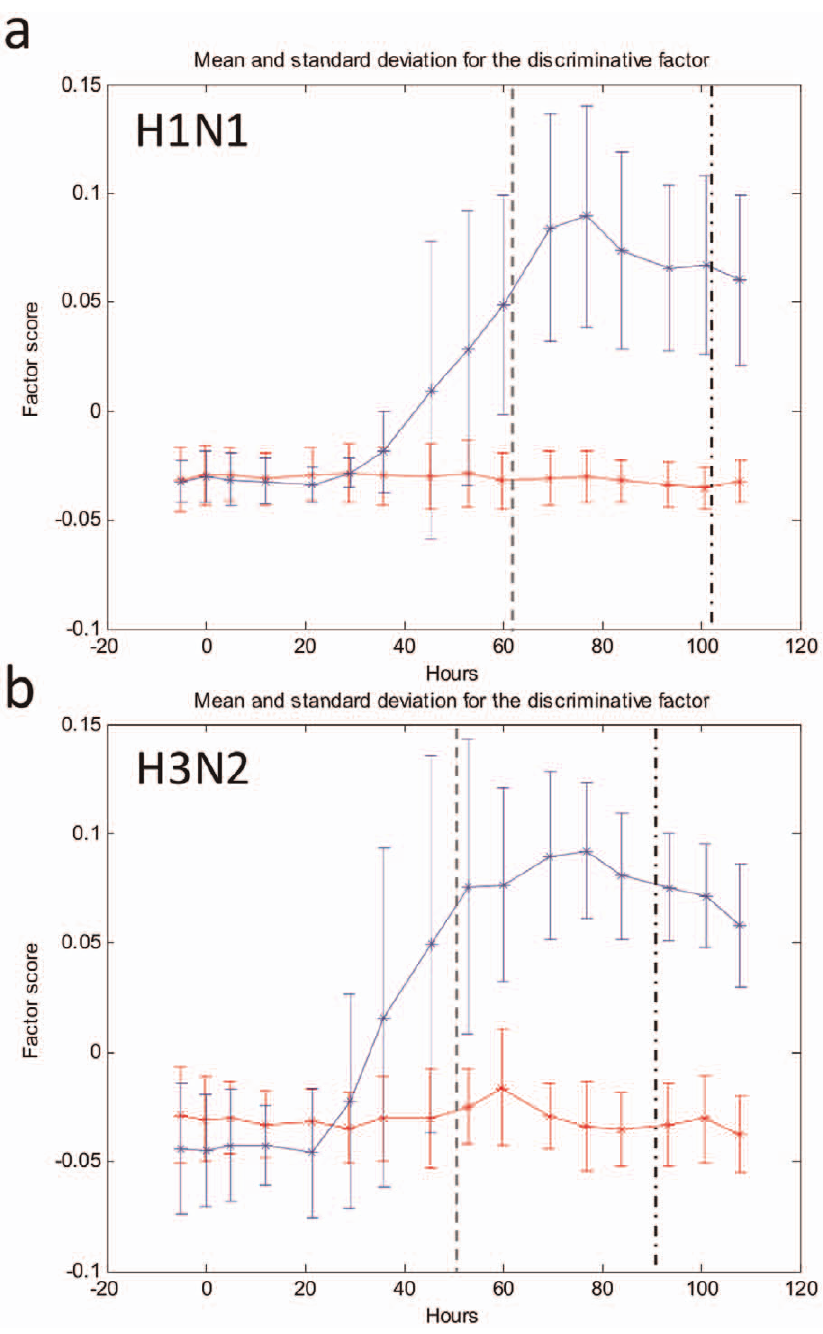
Figure 3. Gene expression signature trajectory over time. The magnitude of the Influenza Factor varies from inoculation through resolution of disease, for both H1N1 (A) and H3N2 (B) patients. The average factor score at each timepoint for both symptomatic (blue) and asymptomatic (red) individuals are shown. The average time of symptom onset (gray dashed line) and maximal symptoms (black dashed line) are depicted.